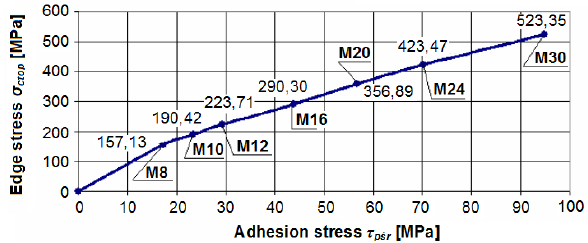
Figure 3: Dependency edge stress – adhesion stress for M8 ÷ M30 anchors in slab short under-window.